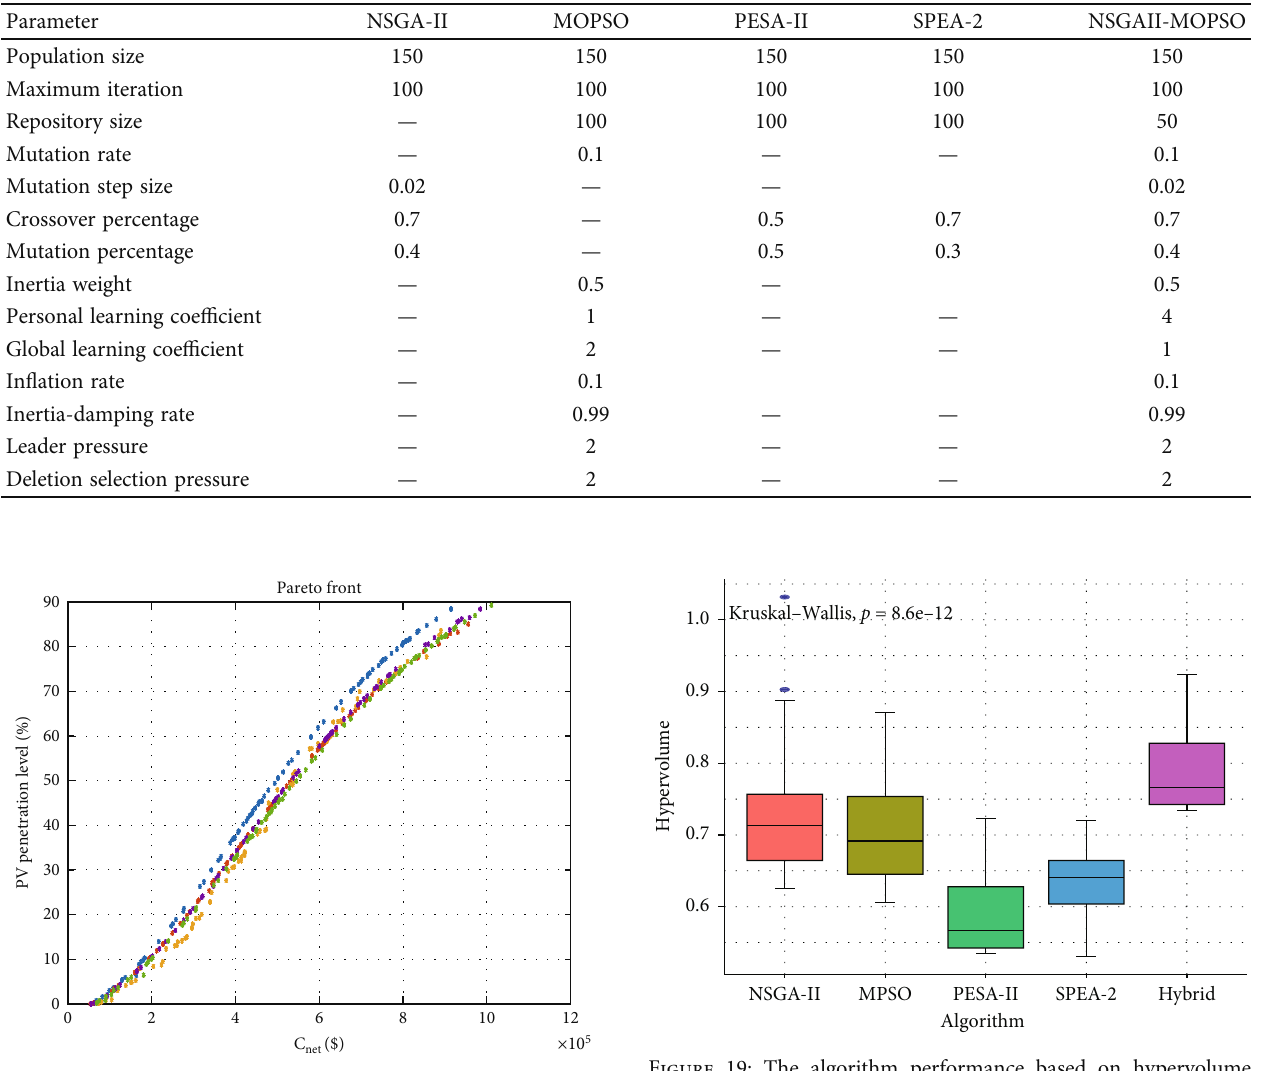
Figure 19: The algorithm performance based on hypervolume